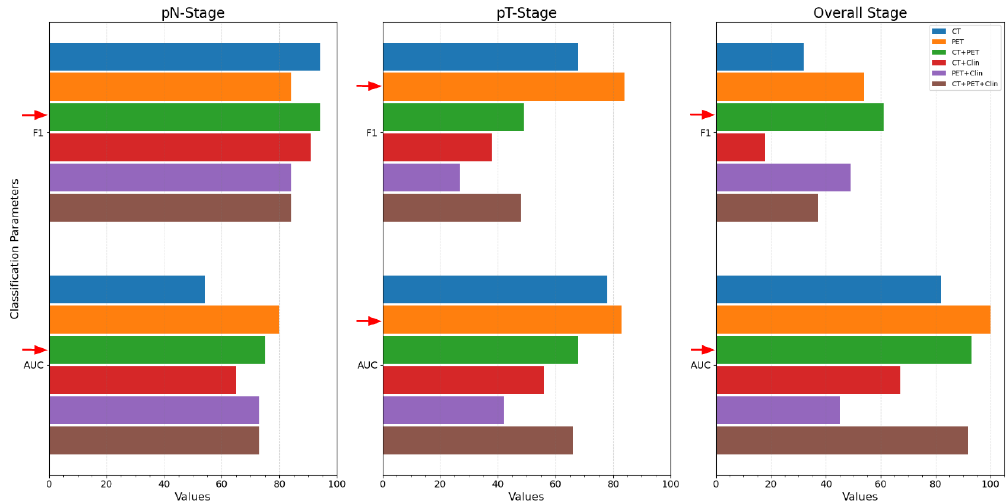
Figure 3. Radiomics features extracted from the original and the wavelet- and LoG-filtered PET and CT images. The red arrows indicate the best results obtained by using the best model in terms of AUC for the LOO-CV strategy on DS 1 . The bar-plot refers to all possible combinations between the features, to obtain higher classification performance (F1 score and AUC), relative to pN-Stage (8 features from CT images and 10 features from PET images), pT-Stage (9 features from PET images) and the Overall Stage (19 features from CT images and 20 features from PET